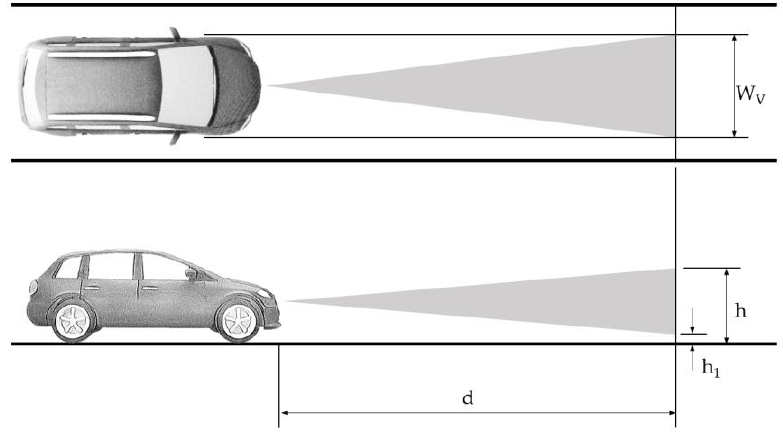
Figure 4. Determination of the FOV for the FVCWS function according to [29].